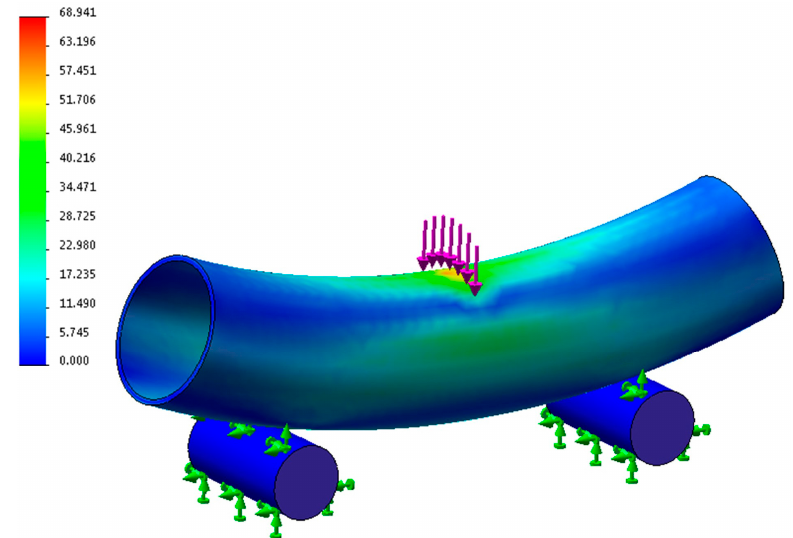
Figure 2. Three-point bending simulation analysis.